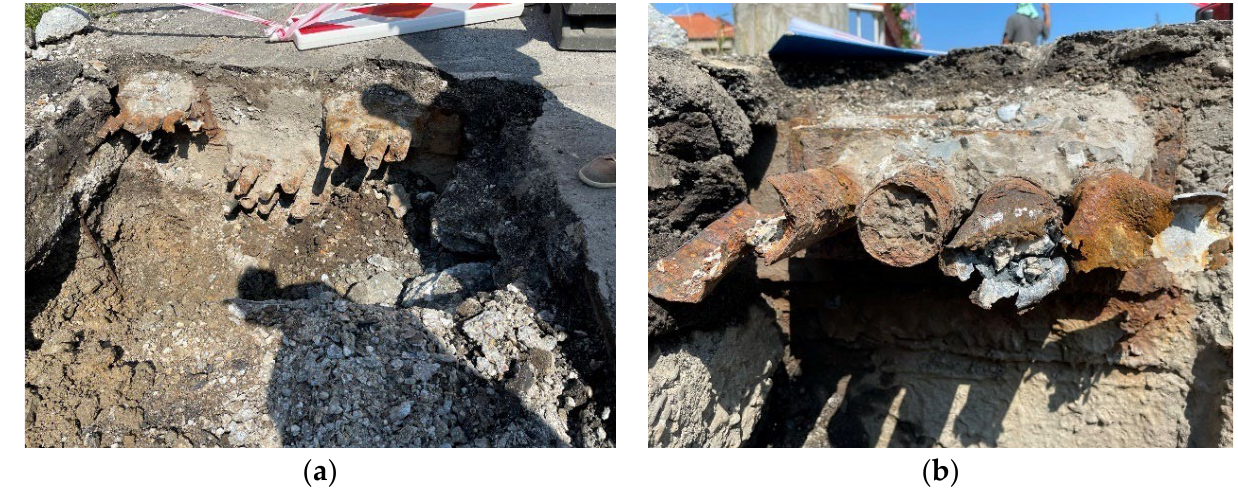
Figure 8. Anchorage area at the end of the beam—view ( a ); detail ( b ).